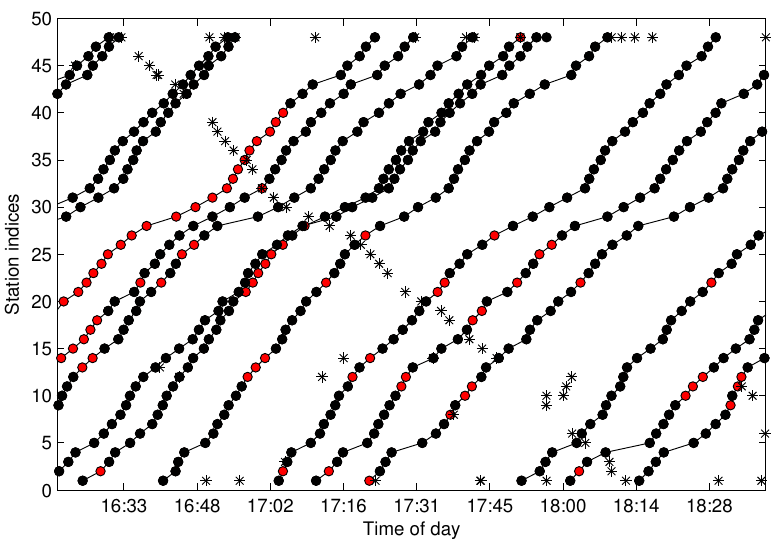
Figure 22. The final recovered